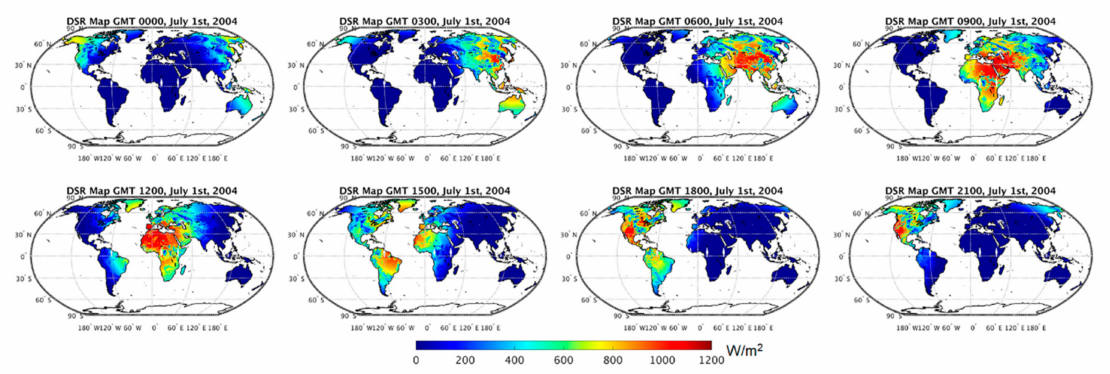
Figure 1. An example of MCD18A1 global 3-h DSR maps of one day generated from MODIS / Terra and MODIS / Aqua